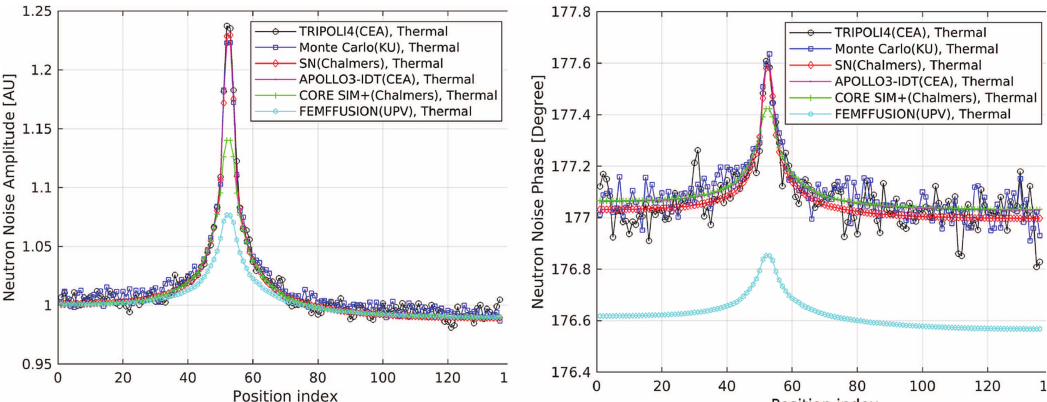
Fig. 3. Spatial variation of the amplitude (left) and phase (right) of the Fourier-transform of the thermal neutron noise induced by a vibrating fuel pin in an infinite fuel assembly lattice in one of the benchmark exercises. Figure derived from [19].